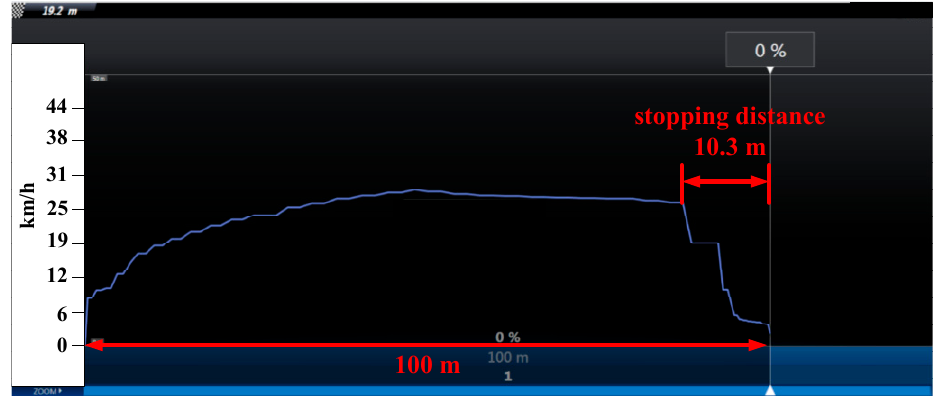
Figure 15. HIL test result of rider of 60 kg, flat road with active regenerative brake.